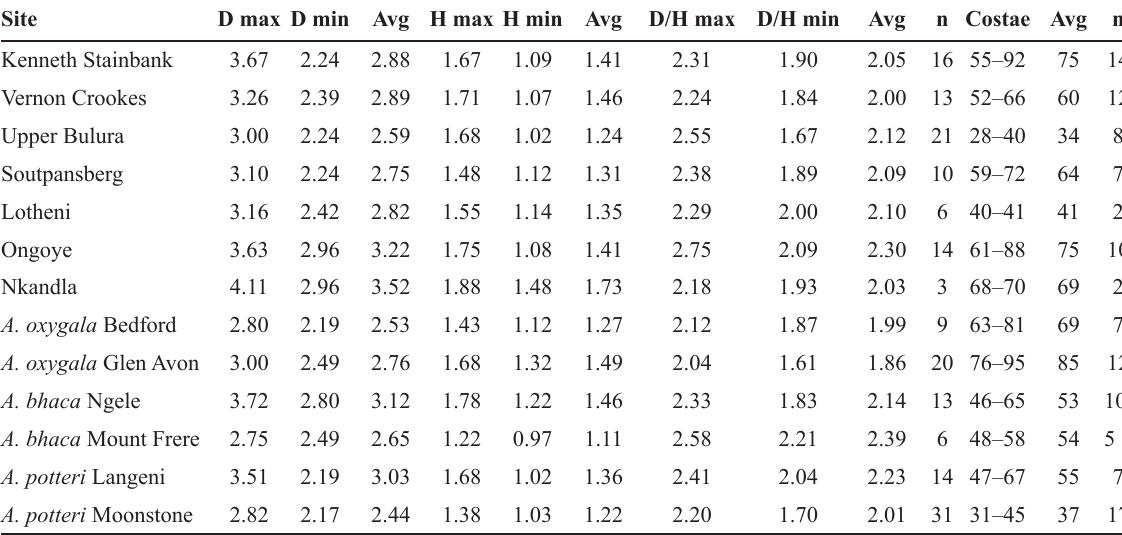
Table 5. Measurements of populations of the Afrocyclus isipingoensis (Sturany, 1898) gen. et comb. nov. species complex; D = shell diameter, H = height, costae = number of axial ribs on body whorl, Avg =